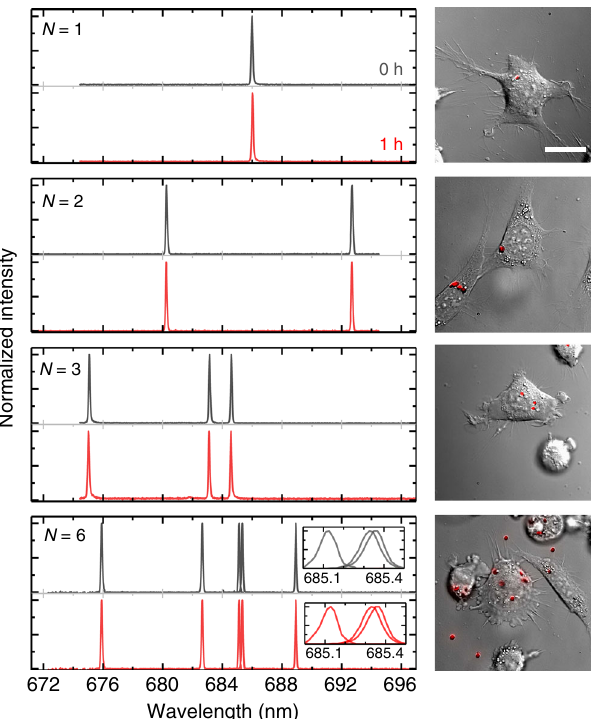
Fig. 4 Demonstration of optical barcoding of cells with multiple nanodisk lasers. Emission spectrum from NIH 3T3 cells with N = 1, 2, 3, and 6 internalized nanodisk lasers, comparing spectra at the beginning of the experiment and after 1 h (left). DIC microscopy images of the same cells with overlaid red fl uorescence from nanodisks (right). Inset for N = 6 shows spectra collected for individual excitation of three lasers with similar emission spectra. Scale bar, 20 µ